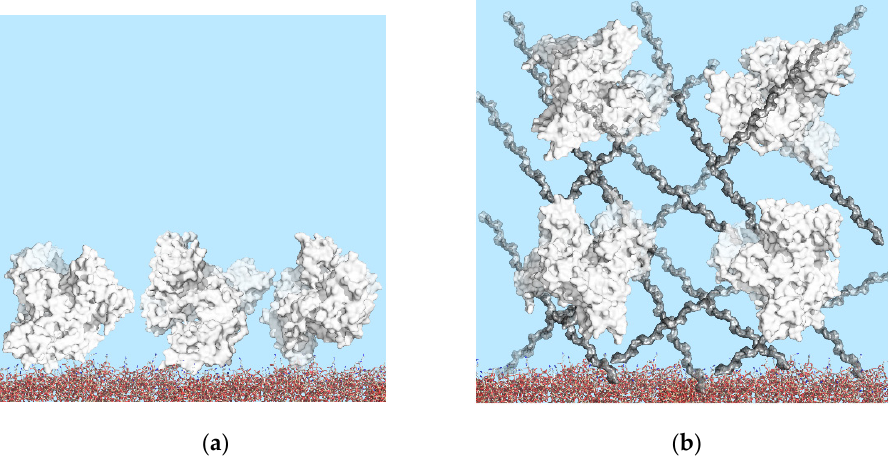
Figure 2. Schematic drawings of immobilized BSA on PC chip surfaces: ( a ) PC chip surface modified with APTES; ( b ) high surface-area-to-volume ratio 3D surface modified with dextrans. Role of surface geometry in binding site